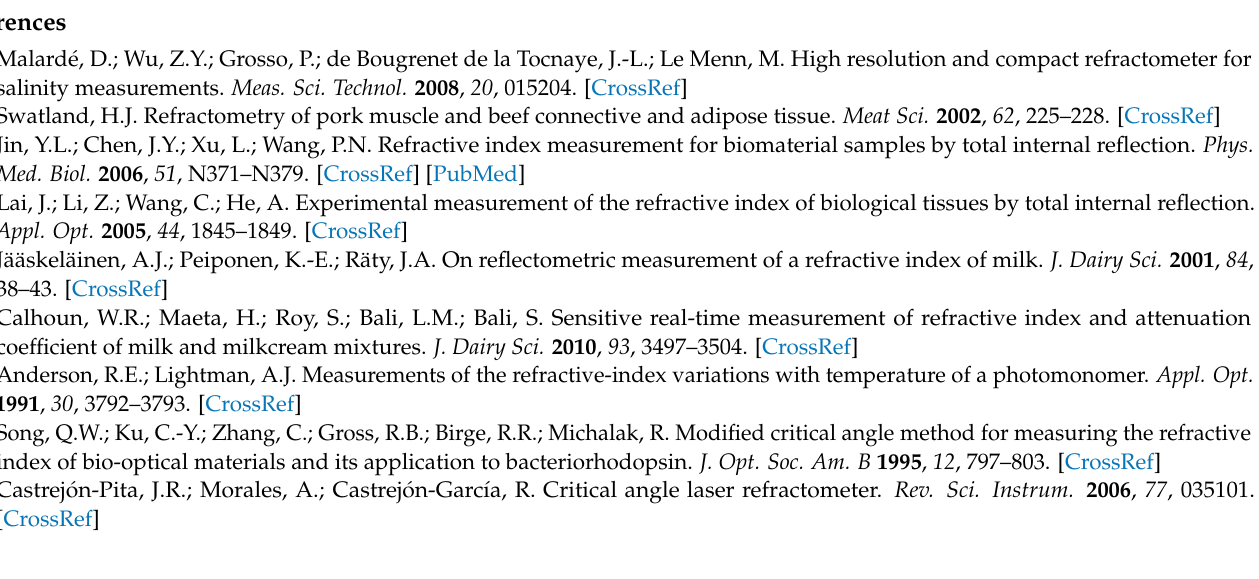
Figure A1. Schematic diagram of the simulated DVD grating. A biolayer of thickness t bio is adhered on the top surface of the grating. Light enters from the backside of the grating at an incident angle of 4 ◦ , and the first-order diffraction efficiency is calculated by the RCWA method. The device surface sensitivity (S Γ )—defined as ∆ η bio / Γ 0 , where ∆ η bio is the difference of η with biolayer and η without biolayer, and Γ 0 = 3.9 × 10 − 14 mol/mm 2 [35] is the biolayer surface density — was calculated to be 1.16 × 10 9 mm 2 /mol. Additionally, simulation of a bulk refractive index variation of ∆ n s = 0.002 (i.e., the RI resolution of the experimental refractometric platform) without the biolayer (t bio = 0) led to a diffraction efficiency variation of ∆ η LOD = − 3.4 × 10 − 6 . Therefore, according to these RCWA calculations, the minimum DNA surface density detectable by the demonstrated smartphone–DVD optosensing configuration would be | ∆ η LOD |/S Γ = 3.4 × 10 − 6 /(1.16 × 10 9 mm 2 /mol) = 3 × 10 − 15 mol/mm 2 , that is, 2 ng/cm 2 (DNA molecular weight = 6281.21 Da [35]).